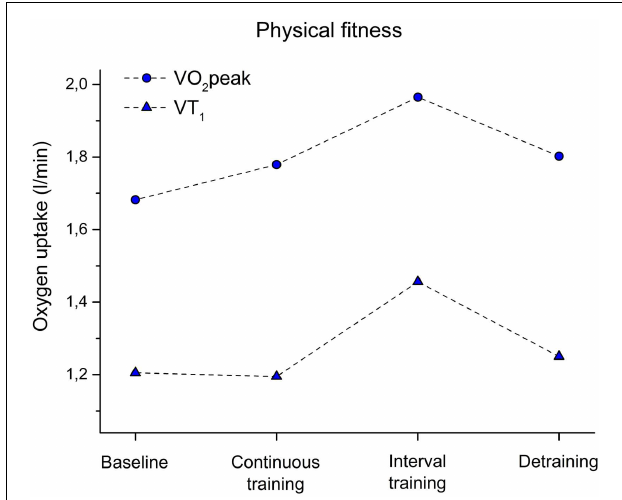
FIGURE 4 | Peak oxygen uptake (VO 2 peak) and oxygen uptake at the ventilatory threshold 1 (VT 1 ) before training (baseline), after 6weeks of continuous training, 6weeks of interval training, and 6weeks of detraining